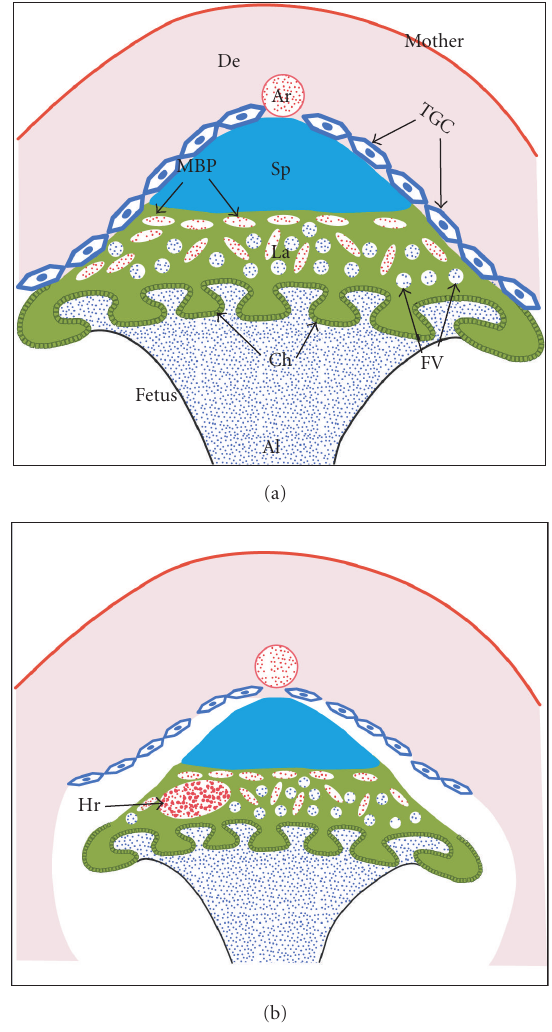
Figure 3: Schematic representation of the Ppard -null phenotype. (a) WT placenta (similar to Figure 2(a)). (b) Ppard -null placenta. Hr: hemorrhage; for all other abbreviations see the legend for Fig- ure 2. Notable di ff erences include smaller and discontinuous giant cells, reduced size of the entire placenta and loosening of its attach- ment to the decidua, and sporadic severe hemorrhages at various locations in or around the